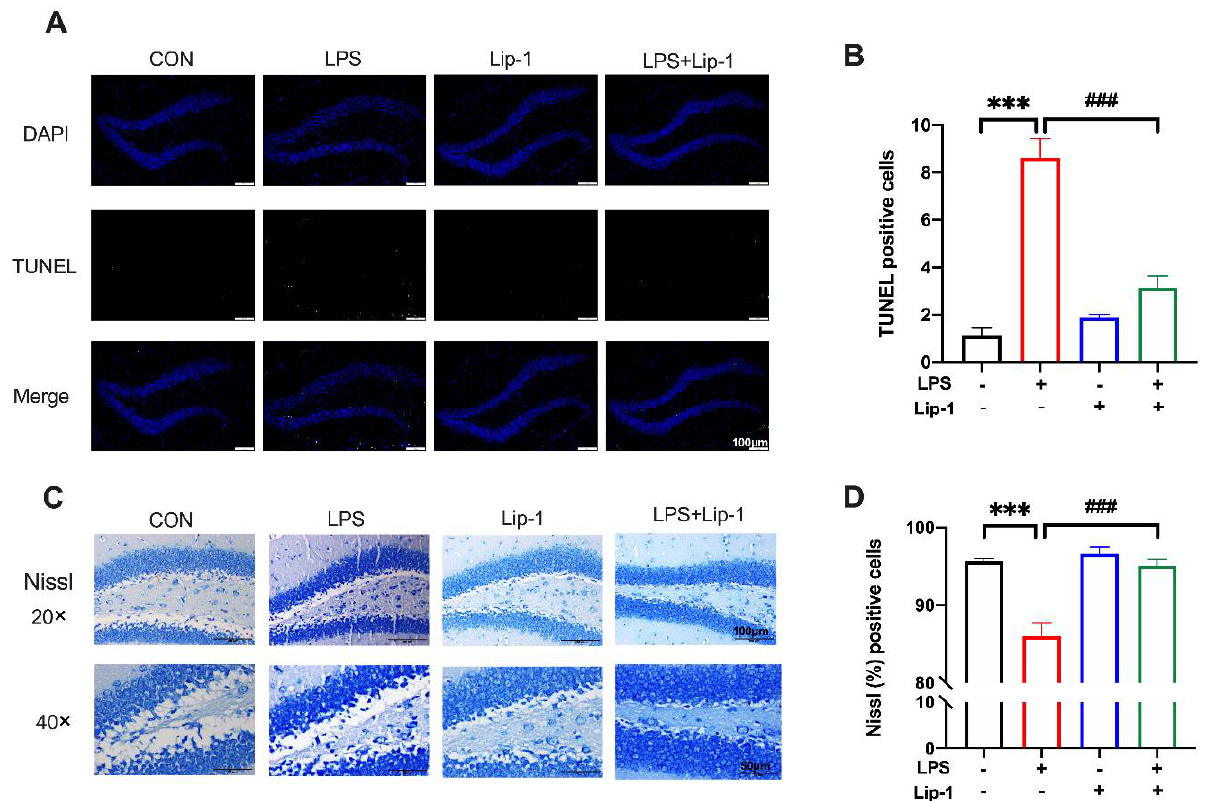
Figure 7. Liproxstatin-1 improved LPS-induced hippocampus neuronal injury. ( A ) TUNEL staining demonstrated cell death in the DG region of the hippocampus in four groups (scale bar = 100 μm). ( B ) The number of TUNEL-positive cells ( n = 4). ( C ) Nissl staining showed morphological neuronal changes in the DG region of hippocampus (scale bar = 100 μm for above and 50 μm for below). ( D ) The percentage of Nissl-positive cells ( n = 5). Data are expressed as mean ± SE. *** p < 0.001 vs. CON group; ### p < 0.001 vs. LPS group.